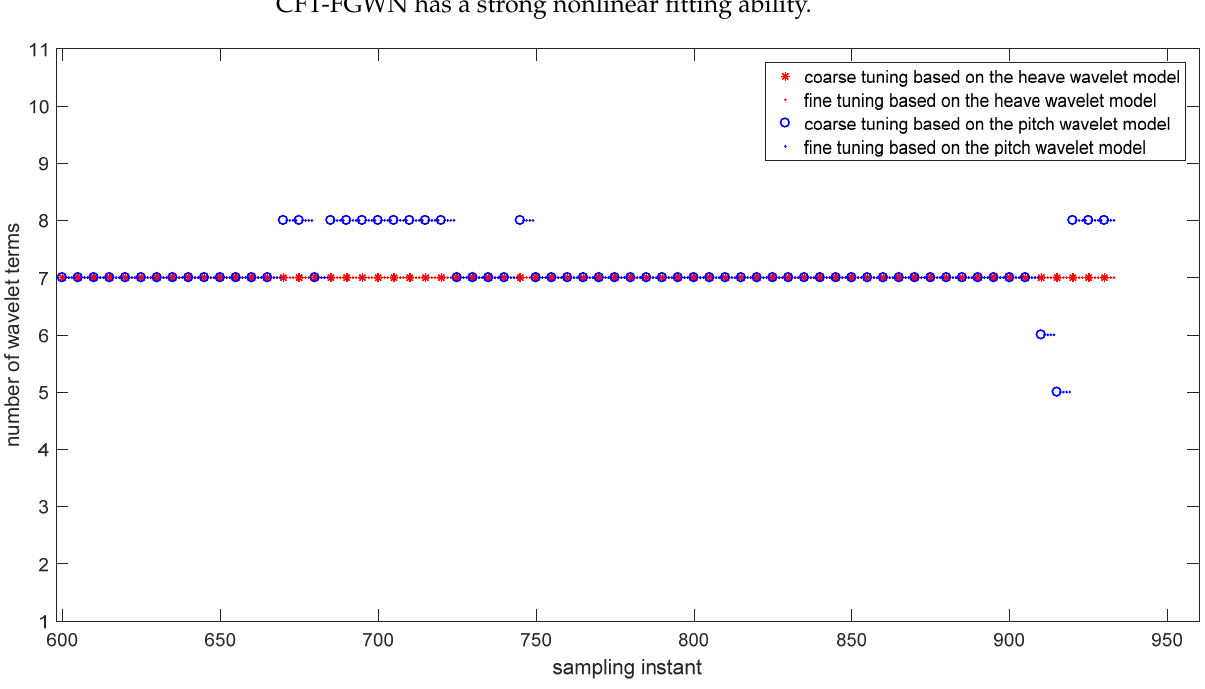
Figure 22. The structure of the CFT-FGWN changing over time based on the experimental data. The computational time of the related modeling algorithm is given in Table 11. It can be seen that the fine-tuning process takes less computational time than the coarse-tuning process. The computational efficiency is improved significantly due to the continuous fine-tuning process.